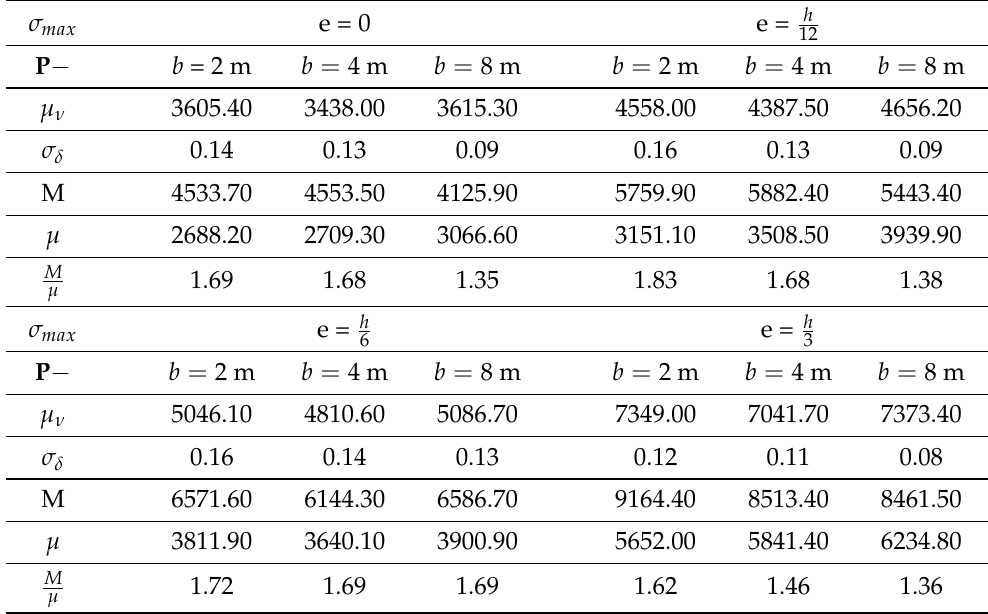
Figure A4. PDFs of the maximum displacement in m for porous analyses with deterministic shape functions for the stochastic material variables. κ L , κ C stands for the linear and constant distribution for κ , respectively, while c D , c R stands for the deterministic and random distribution for c, respectively, and k R , k D stands for the random and deterministic distribution for k. Subplot ( a – d ) stand for eccentricity 0, h , h , h , respectively. 6 3 12 Table A3. Monte Carlo results for the maximum stress kPa the normal force kN, the maximum and minimum displacements m and the rotation of the foundation rad for porous analyses with random field representation for the stochastic material variables. µ ν , σ δ , M, µ stand for the mean value, the coefficient of variation, the maximum and the minimum value of the output random vector. σ max , N, u max , u min , φ denote the maximum footing settlement stress, the foundation axial force at failure, the maximum failure displacement, the minimum failure displacement and the corresponding rotation of the shallow foundation,